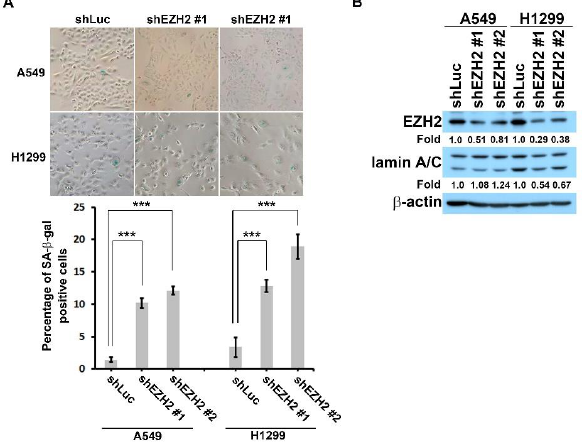
Figure 4. EZH2 knockdown induces cellular senescence in non-small cell lung cancer cells. ( A ) A549 or H1299 cells were transfected with shRNA to deplete EZH2 and incubated for 4 days. SA- β -Gal staining was employed to measure the percentage of senescent cells (β -gal-positive cells). The bar chart shows that <3% of cells in the shLuc population were SA- β -gal-positive, whereas more than 10% of the shFAK cells population were SA- β -gal positive, based on three independent experiments ( n > 250). *** p < 0.001 according to a Student’s t -test. ( B ) A549 or H1299 cells were treated with shRNA to deplete EZH2, lysed, and subjected to Western blot analysis. Protein levels were detected using the indicated antibodies. As a loading control, an anti- β -actin antibody was used. The numbers below the blot images indicate the relative intensity of EZH2 or lamin A/C signal relative to the β -actin signal. 3.4. EZH2 Overexpression Attenuates FAK-Inhibition-Induced Cellular Senescence in Non-Small Cell Lung Cancer Cells